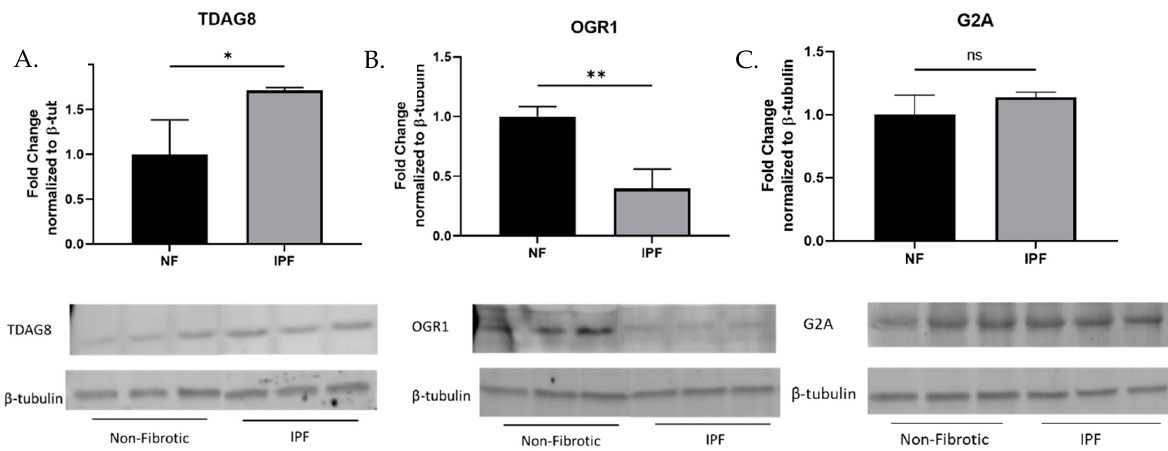
Figure 1. Proton sensing G-protein coupled receptors are expressed in primary human lung fibro- blasts. Primary human lung fibroblasts were cultured in six-well plates and grown to a confluency of 85% before protein was harvested to examine expression of TDAG8 ( A ), OGR1 ( B ), and G2A ( C ). Data were analyzed by t -test. n = 3/group. * p < 0.05, ** p < 0.01, ns= not statistically significant. All samples were run on the same gel; however, non-contiguous lanes are denoted with a line.